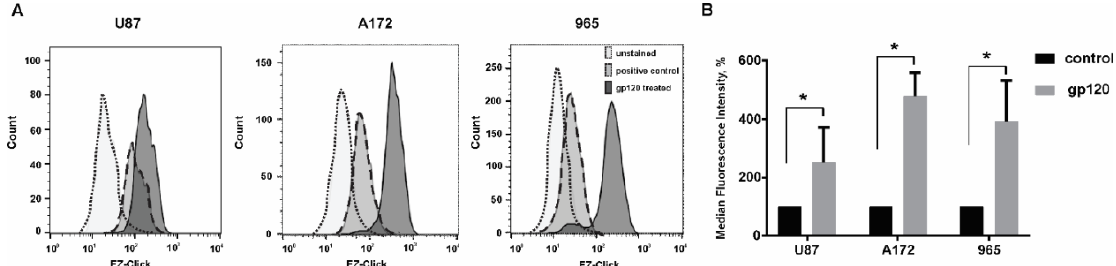
Figure 10. Gp120 increases global protein synthesis in glioma cells. EZClick Global Protein Synthesis Assay Kit (BioVision Inc, Milpitas, CA, USA), followed by flow cytometry analysis, was used for the identification of de novo synthesis of polypeptides. Experiments were performed for untreated glioma cells and cells continuously treated with gp120 for 7–10 days. U87 and A172 cell lines and 965 primary glioma cells were investigated. ( A ) Graphs represent the total distribution of stained cells in gp-120 treated and untreated glioma cell lines. ( B ) The relative median fluorescence intensity is calculated as a percentage of median fluorescence intensity in cells treated with gp120 relative to untreated cells. Mean ± S.E. and significant differences between gp120-treated and untreated groups (*) are shown ( p < 0.05). Unpaired t -tests were used to determine the significance between groups. Four repeated experiments ( n = 4) were used for statistical analysis.